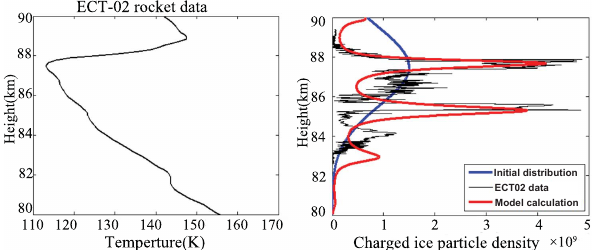
Figure 4. The vertical profile of the temperature (left) and charged ice density distribution (right) from the ECT02 rocket sounding (black line). The initial distribution of charged ice particles (blue line) and the model calculation results (red